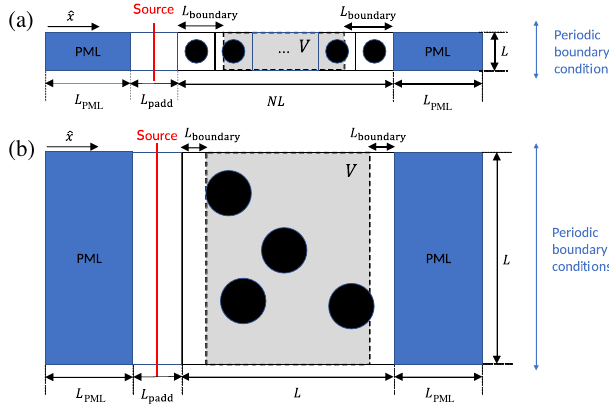
FIG. 7. Schematic of the general simulation setup for either (a) periodic or (b) nonperiodic composites consisting of N spheres of radius a in a matrix. In both cases, Gaussian pulses of electric fields propagate from the planar sources (shown in red lines) to the packings (shown in black circles). The wave number (spectrum) of the pulses spans between min ½ k 1 (cid:2) and max ½ k 1 (cid:2) . Periodic boundary conditions are applied along all directions, except for the propagation direction ˆ x . The perfectly matched layers (PML shown in blue) of thickness L are placed at both PML ends of the simulation box to absorb any reflected and transmitted waves. To estimate the effective dielectric constant as described in step 2 below, we consider the subregion V (shown in gray) that excludes from the composite within the simulation box two relatively thin slabs of thickness L along the propagation boundary